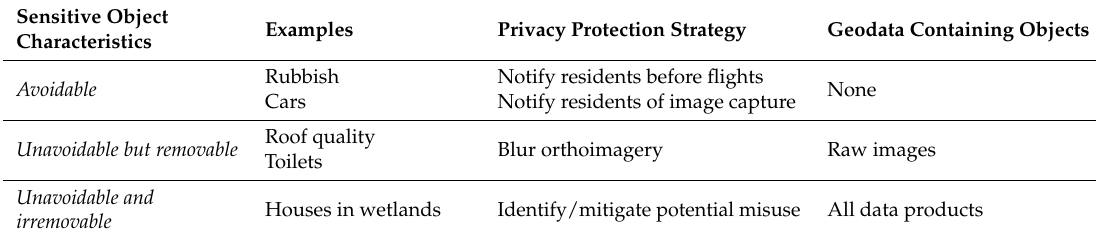
Table 2. Categories of sensitive objects and possible strategies to address residents’ concept of sensitive